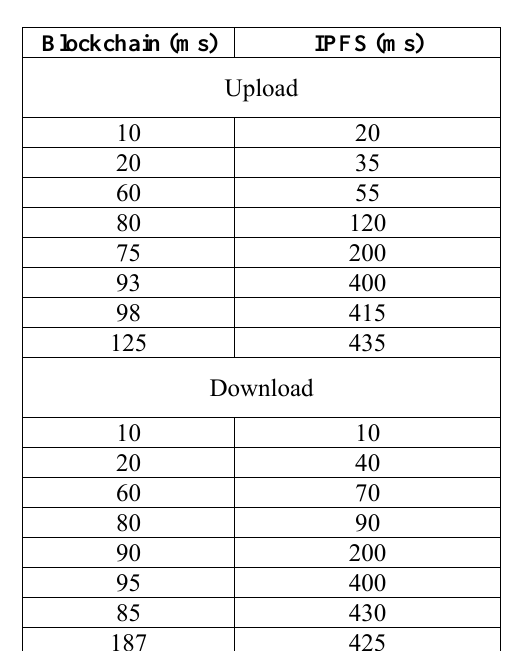
Fig. 5.3. Comparison of download transactions between IPFS and Blockchain